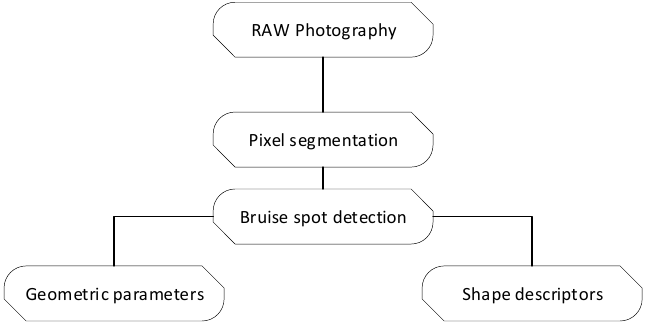
Figure 1. General image analysis workflow.